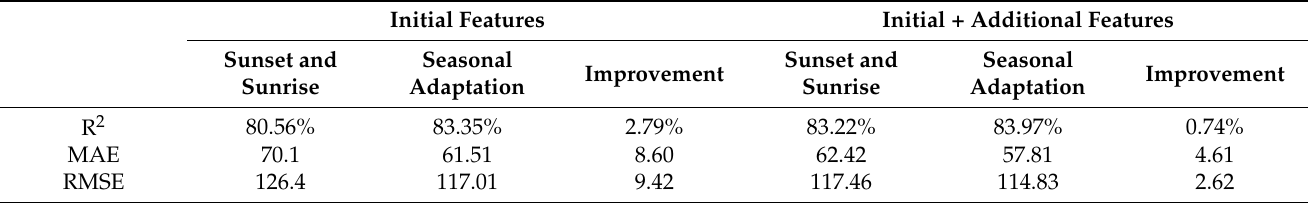
Table 6. Comparison of influence on seasonal adaptation on FBP models with different features.